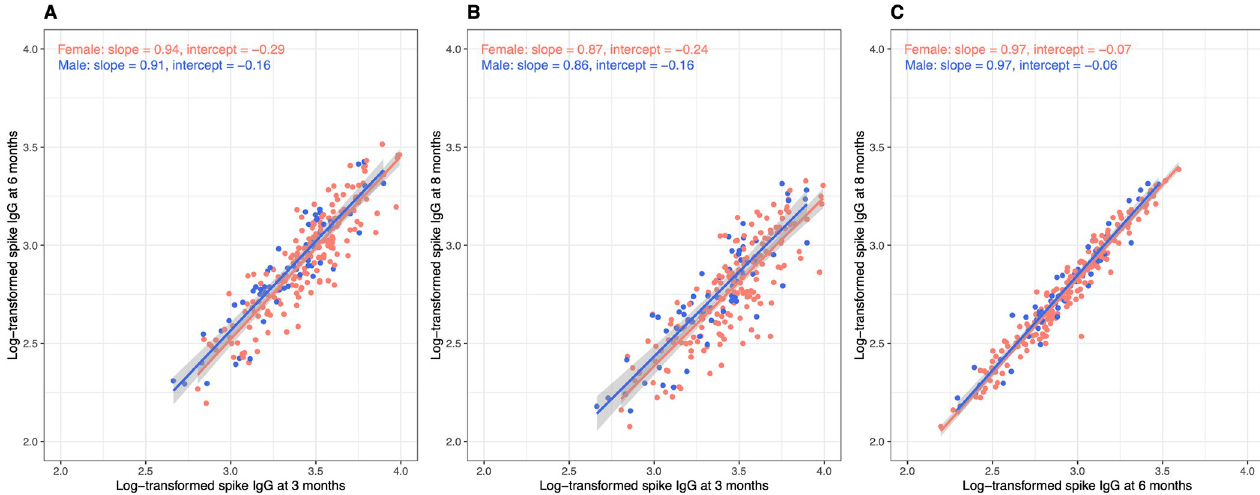
Fig 3. A linear regression analysis between spike IgG level at 3 and 6 months (panel A), at 8 months (panel B), and at 6 and 8 months (panel C), stratified by gender.